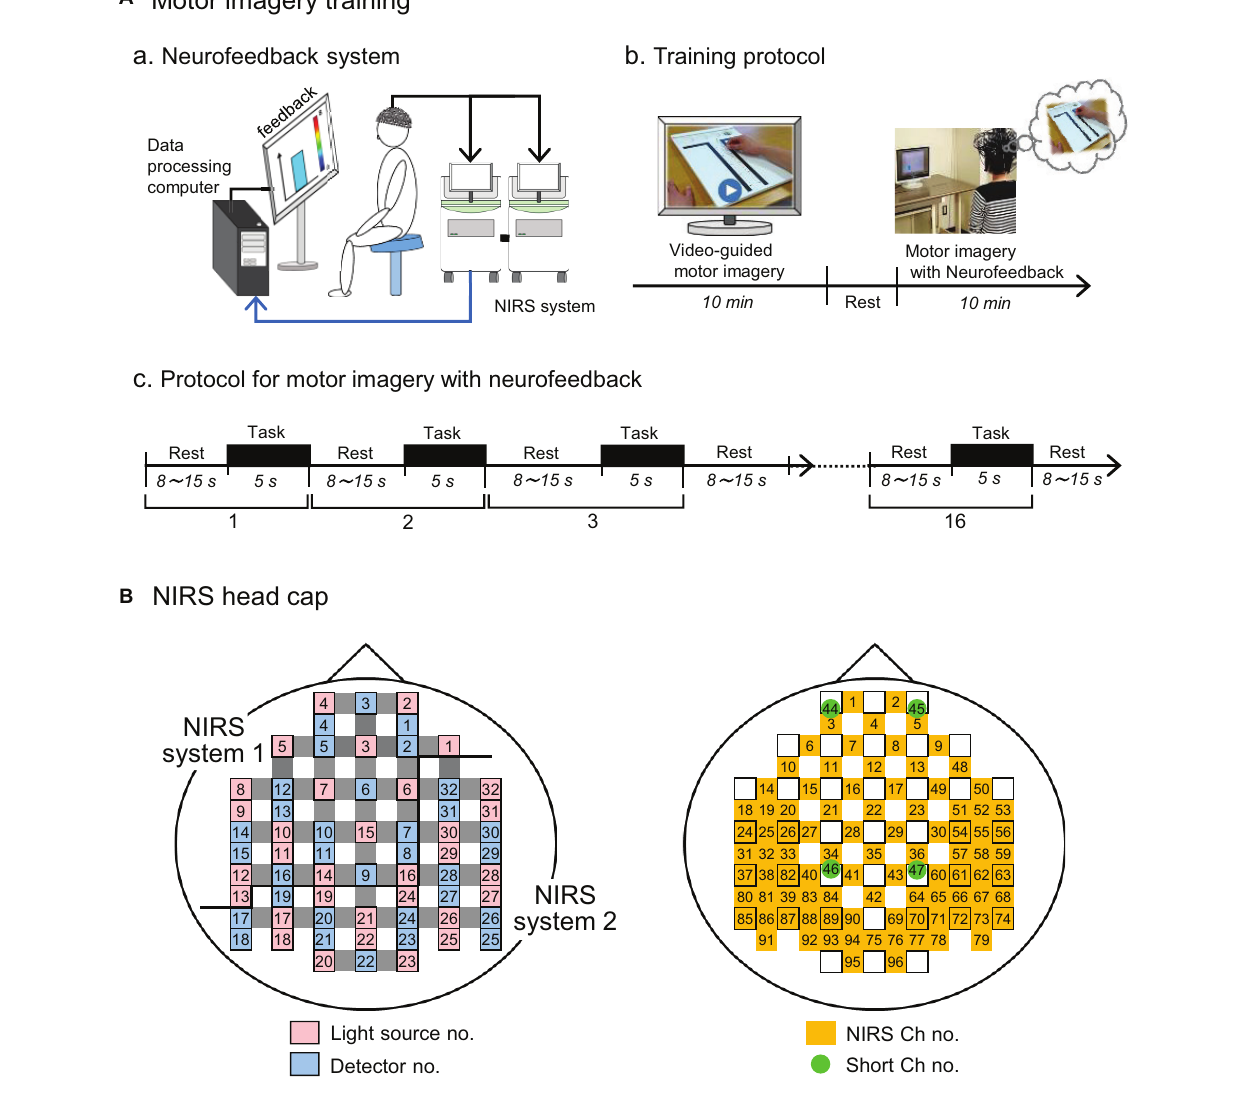
FIGURE 2 | Motor imagery training using fNIRS neurofeedback system. (A) Motor imagery training. (a) A schematic figure of the fNIRS-mediated neurofeedback system. (b) Protocol for motor imagery training. Motor imagery training consisted of video-guided motor imagery and motor imagery with neurofeedback. (c) Protocol for motor imagery with neurofeedback. The training protocol consisted of 16 trials. Each trial consists of 5-s motor imagery and 8 -15-s rest periods. (B) Arrangement of probes and channels in an fNIRS head cap. As the source of feedback signals, 5 fNIRS channels in the aPFC (Ch 1-5) were used. NIRS ch